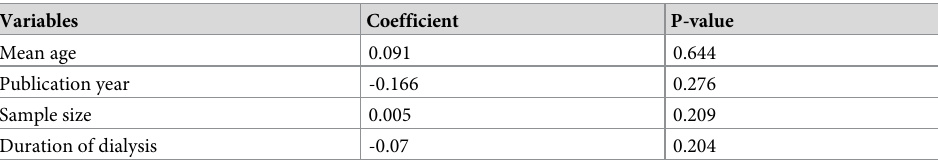
Table 4. Meta-regression of factors associated with heterogeneity in this